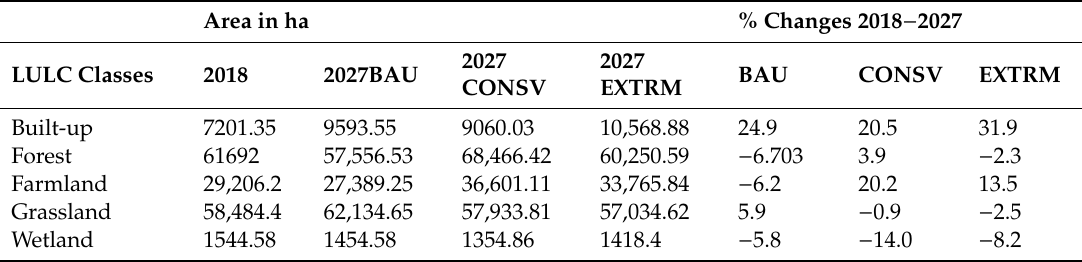
Table 9. Areal changes from 2018–2027 under the three scenarios (BAU: business as usual scenario; CONSV: conservation scenario; EXTRM: extreme